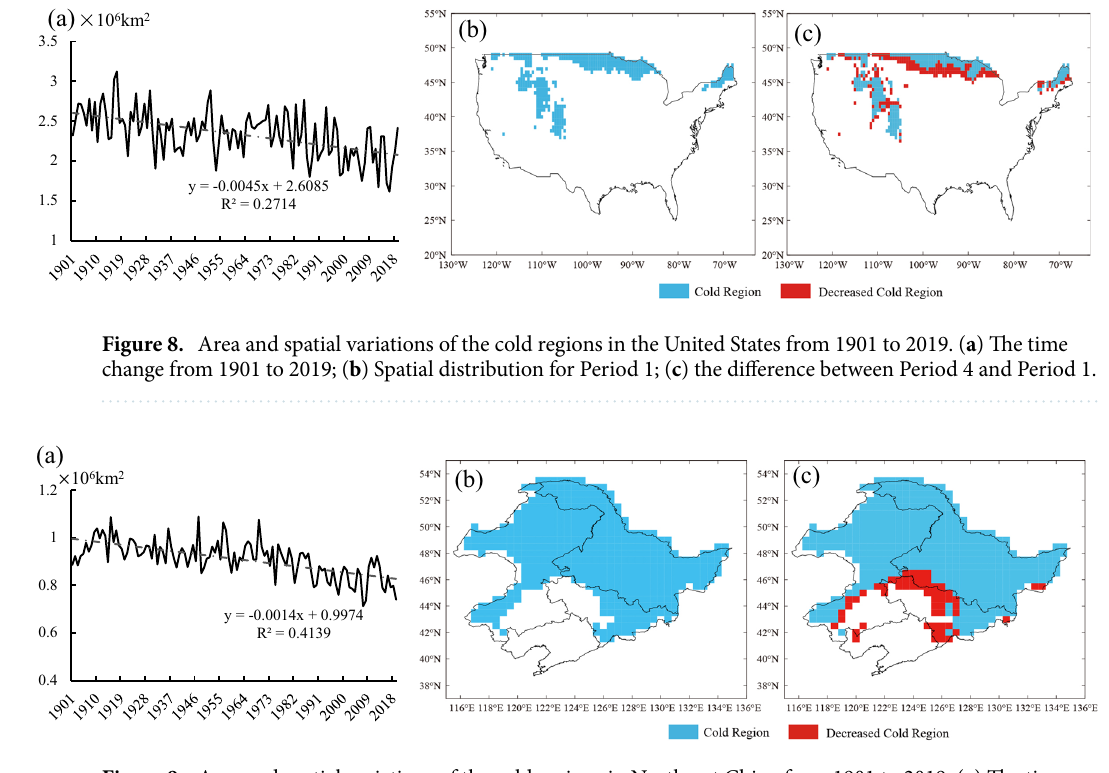
Figure 9. Area and spatial variations of the cold regions in Northeast China from 1901 to 2019. ( a ) The time change from 1901 to 2019; ( b ) Spatial distribution for Period 1; ( c ) the difference between Period 4 and Period